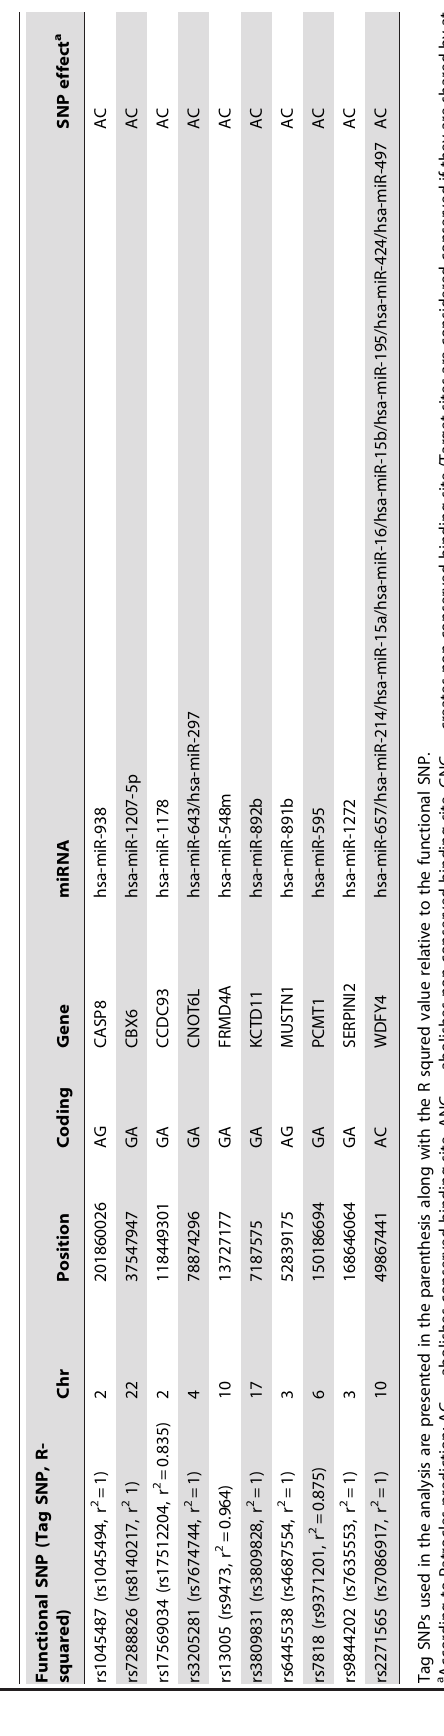
1.03 [95%CI 1.01–1.05]; P =7.75 6 10 2 4 ) a more